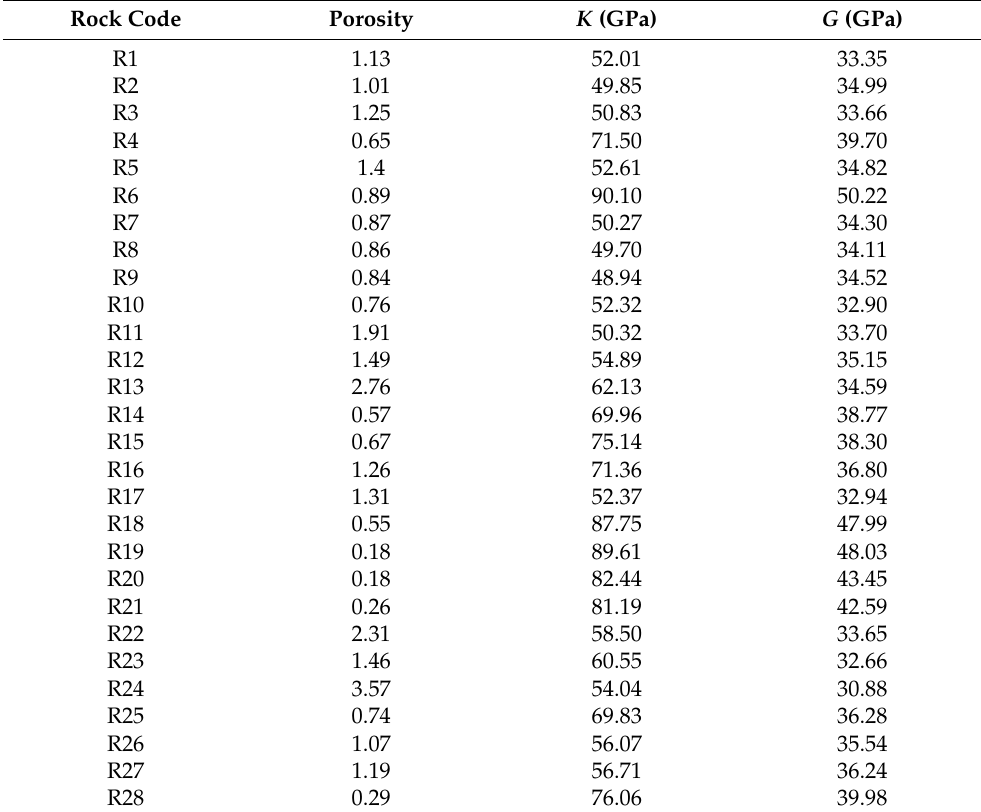
Table 4. Porosity, computed effective shear modulus and computed effective bulk modulus of the studied rocks. Rock